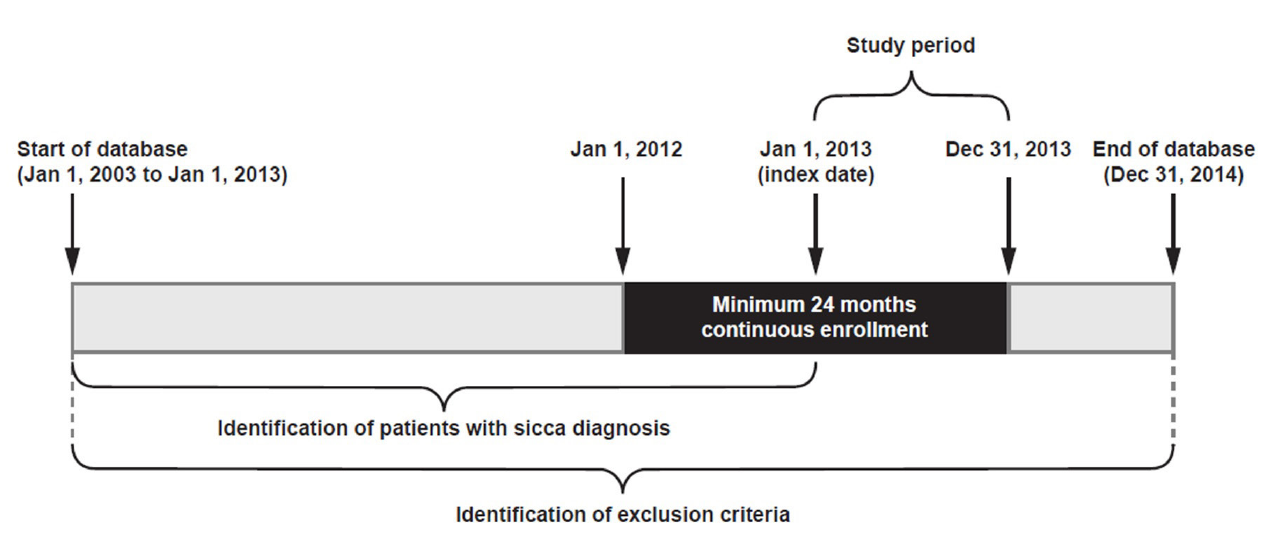
Figure 1. Primary Cohort